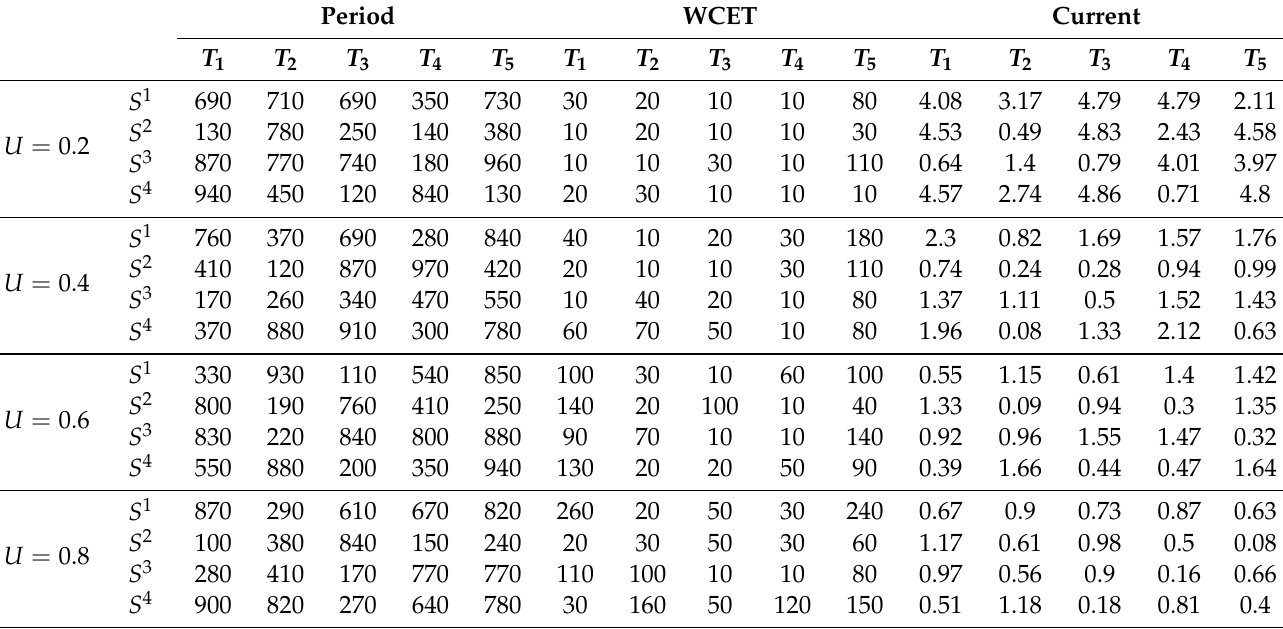
Table 1. Randomly generated task sets used for the battery lifetime